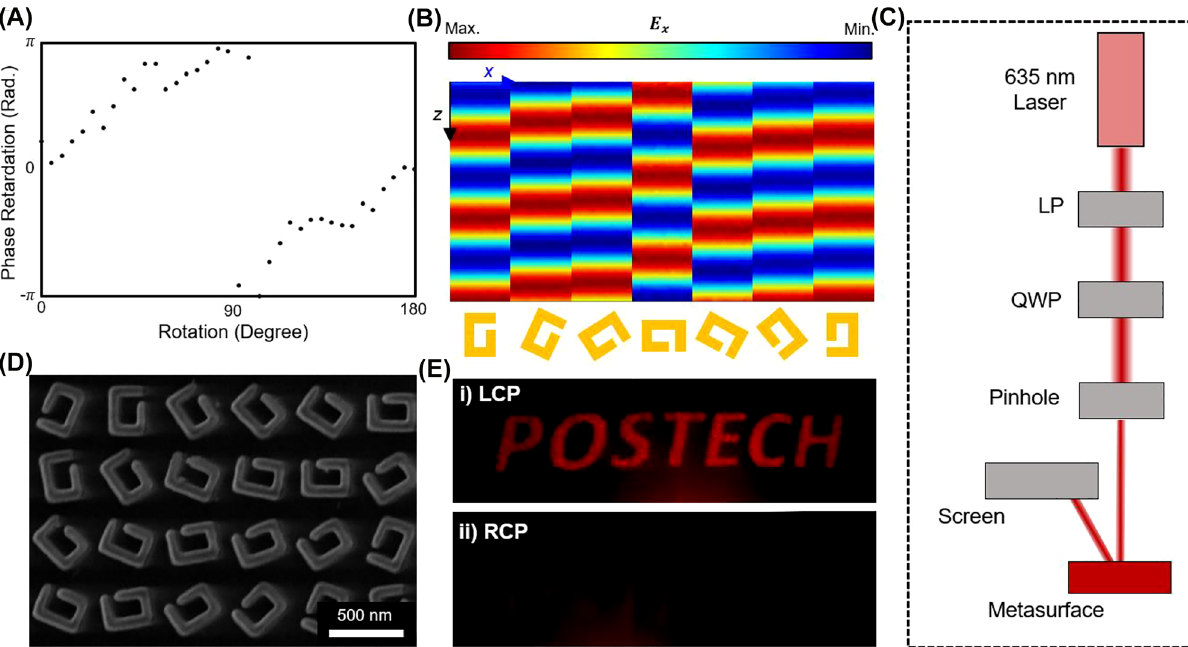
Figure 4: Demonstration of the spin-selective chiral metasurface. (A) Simulation of phase retardation depending on the rotation angle of the gap-shifted SRRunderLCP.WhenLCP isincident tothemetasurface,the phaseof outputlightisretardedproportionalto therotationangleof gap-shifted SRRs. (B) Normalized electrical field E x of the re fl ected light from rotated gap-shifted SRR that shows the PB phase of the chiral nanostructure under incident LCP. (C) Optical setup designed with 635 nm laser, linear polarizer (LP), quarter-wave plate (QWP), and 300 μ m diameterpinholefortheproofofconceptofthespin-selectivemetahologram.Holographicmetasurfacewasdesignedasanoff-axishologram to avoid overlapping of zeroth-order diffraction light and hologram image. (D) Top view scanning electron microscope image of the fabricated metasurface.(E)Holographicimage ‘ POSTECH ’ isobtainedunder(i)incidentLCP,anddisappearsunder(ii)RCP.Twinimagesarenotobtained under both RCP and LCP, which are omitted from the fi gure for